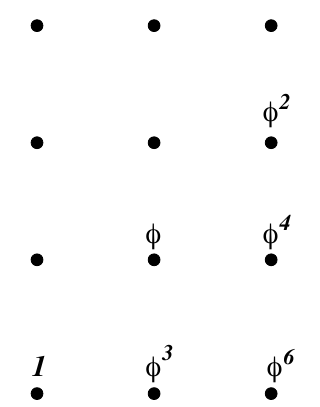
Figure 2: Landau-Ginzburg assignment of bulk operators in the A